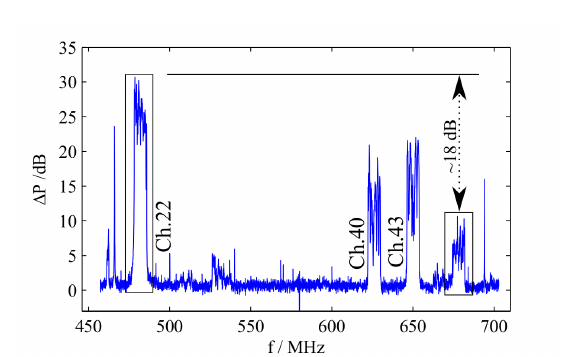
Figure 18. Calibrated PSD output to achieve a flat noise floor. The calculation is performed using 100 averages. Three TV channels can be observed at 482 MHz, 626 MHz and 650 MHz with their corresponding image signals, with 18 dB image suppression.